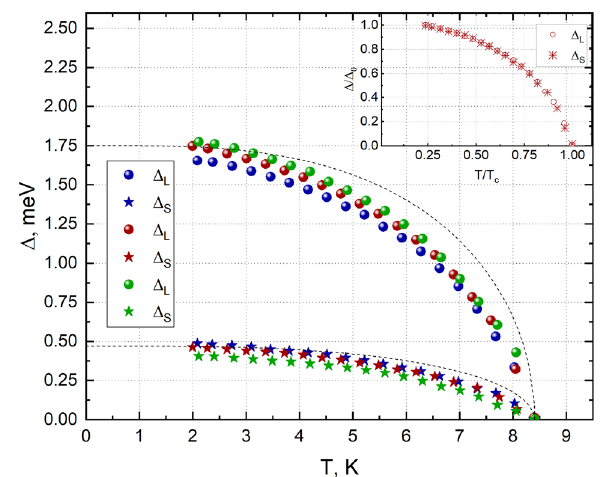
Fig. 5 Temperature dependences of gap values. Inset shows scaled temperature dependencies for both large and small gaps. Dashed lines represent a BCS-like